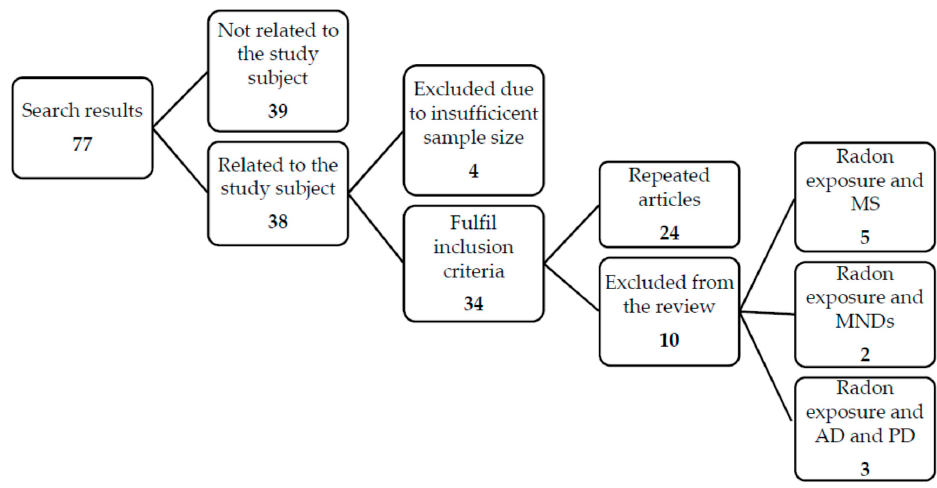
Figure 1. Search summaryforallterms’ combinations.